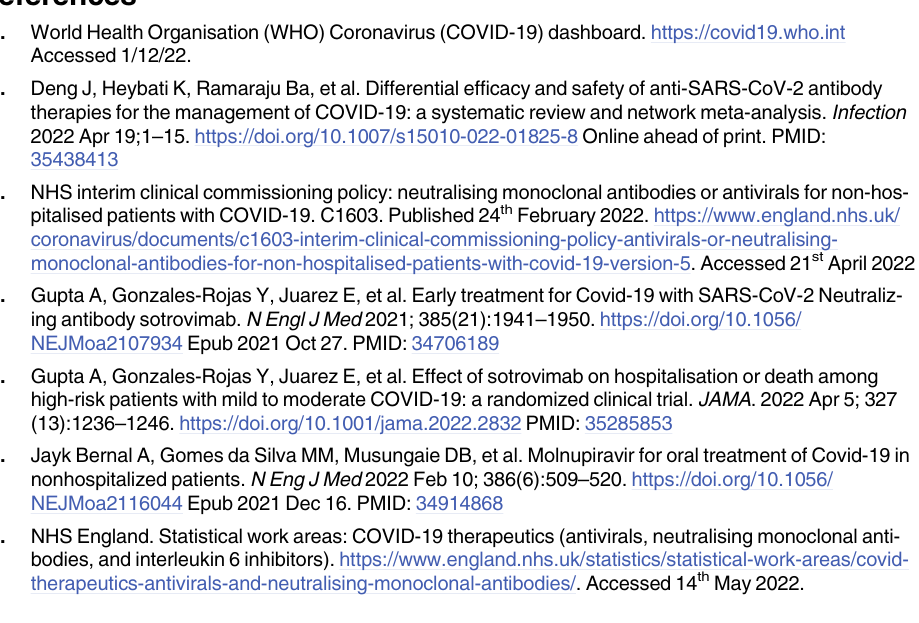
S1 Table. Demographic and clinical details of patients that received